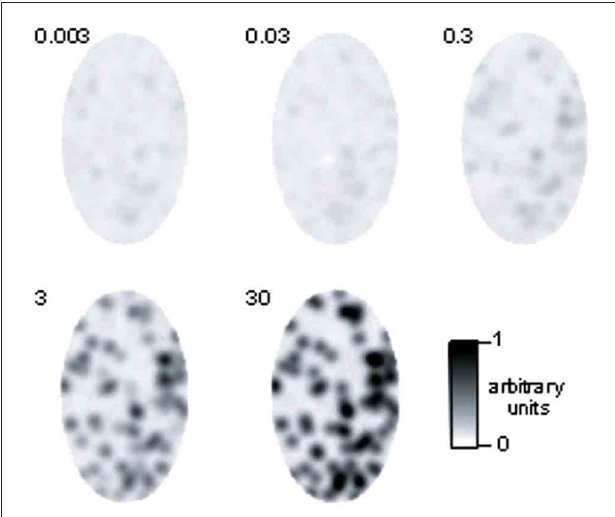
FIGURE 4 | Population response to an odor at different concentrations in the model. The depicted region corresponds to the dorsal part of the OB that has been visualized using intrinsic imaging methods [Rubin and Katz (1999); Uchida et al. (2000); Meister and Bonhoeffer (2001)]. M/TC activity was converted to gray scale values as described in the methods.